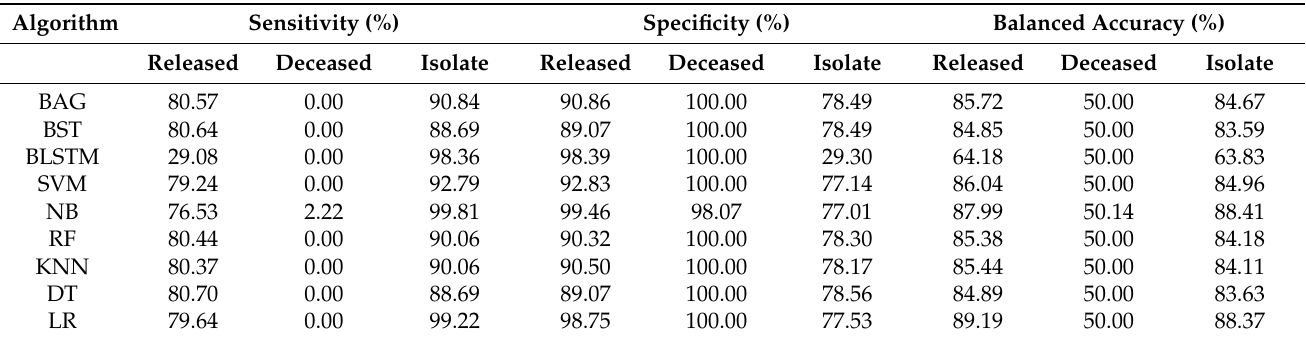
Table 2. Performance Metrics of BAG, BST, BLSTM, SVM, NB, RF, KNN, DT, and LR.